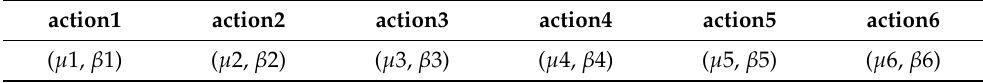
Table 3. The corresponding form of actions and parameters in the ant colony module.